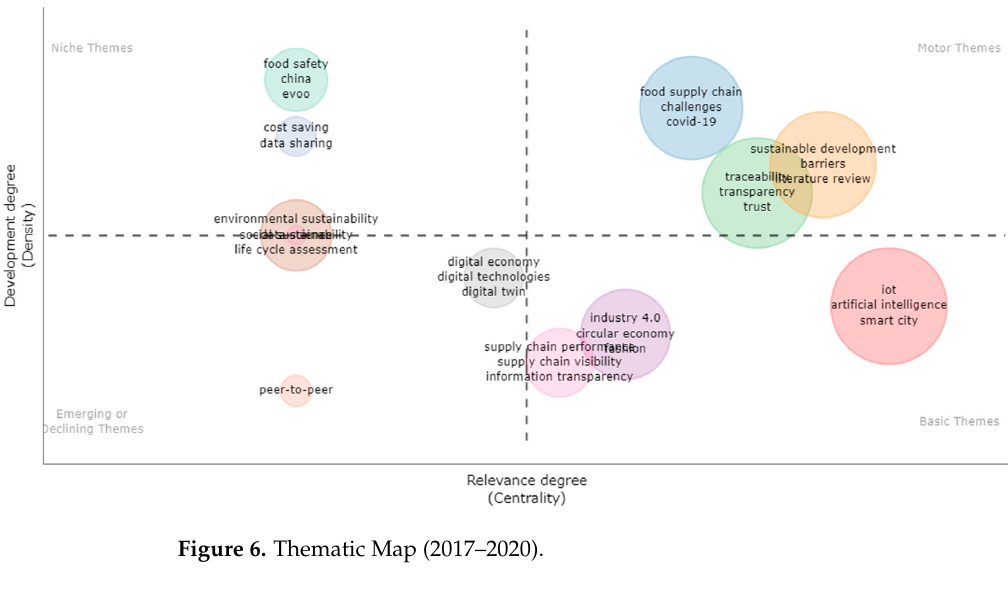
Figure 6. Thematic Map (2017 – 2020).